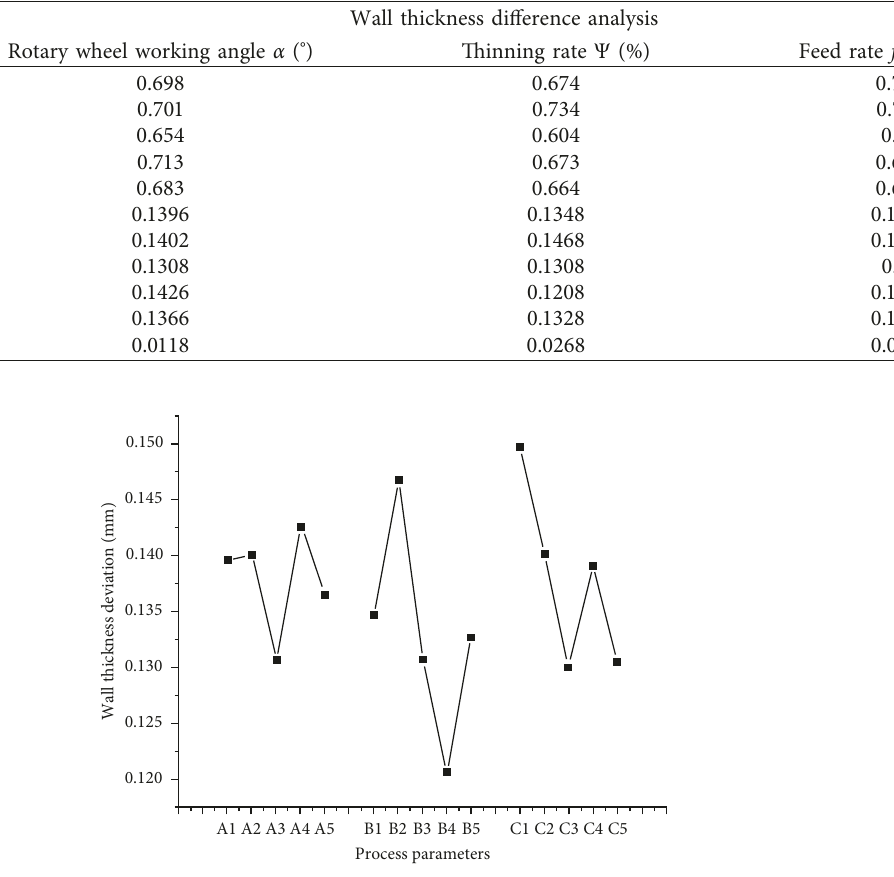
Table 5: Wall thickness difference analysis results.